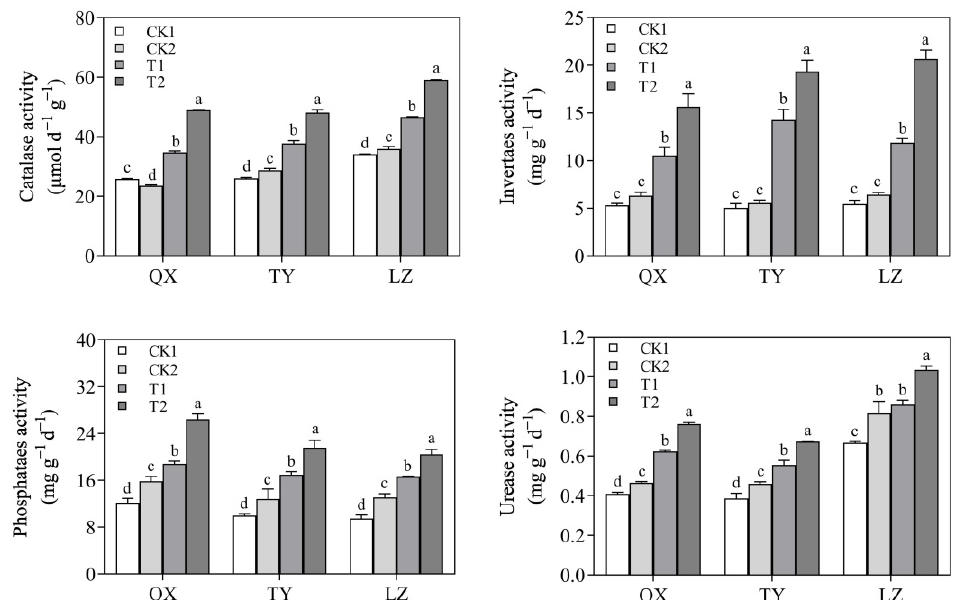
Figure 1. Effect of different treatments on soil enzyme activity in three places. LZ: Laizhou, QX: Qixia, TY: Yiyuan. CK1: replant control, CK2: methyl bromide fumigation, T1: blank carrier treatment, T2: QSB-6 bacterial fertilizer treatment. Columns with the same letter for each place are not significantly different based on the Duncan multiple range test at p < 5%.